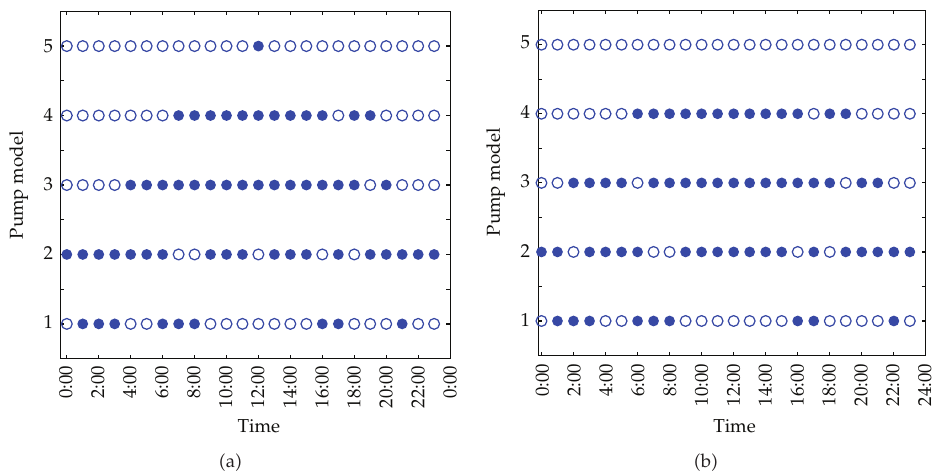
Figure 10: (cid:2) a (cid:3) Operation state of the form model. (cid:2) b (cid:3) Operation state of the new improved